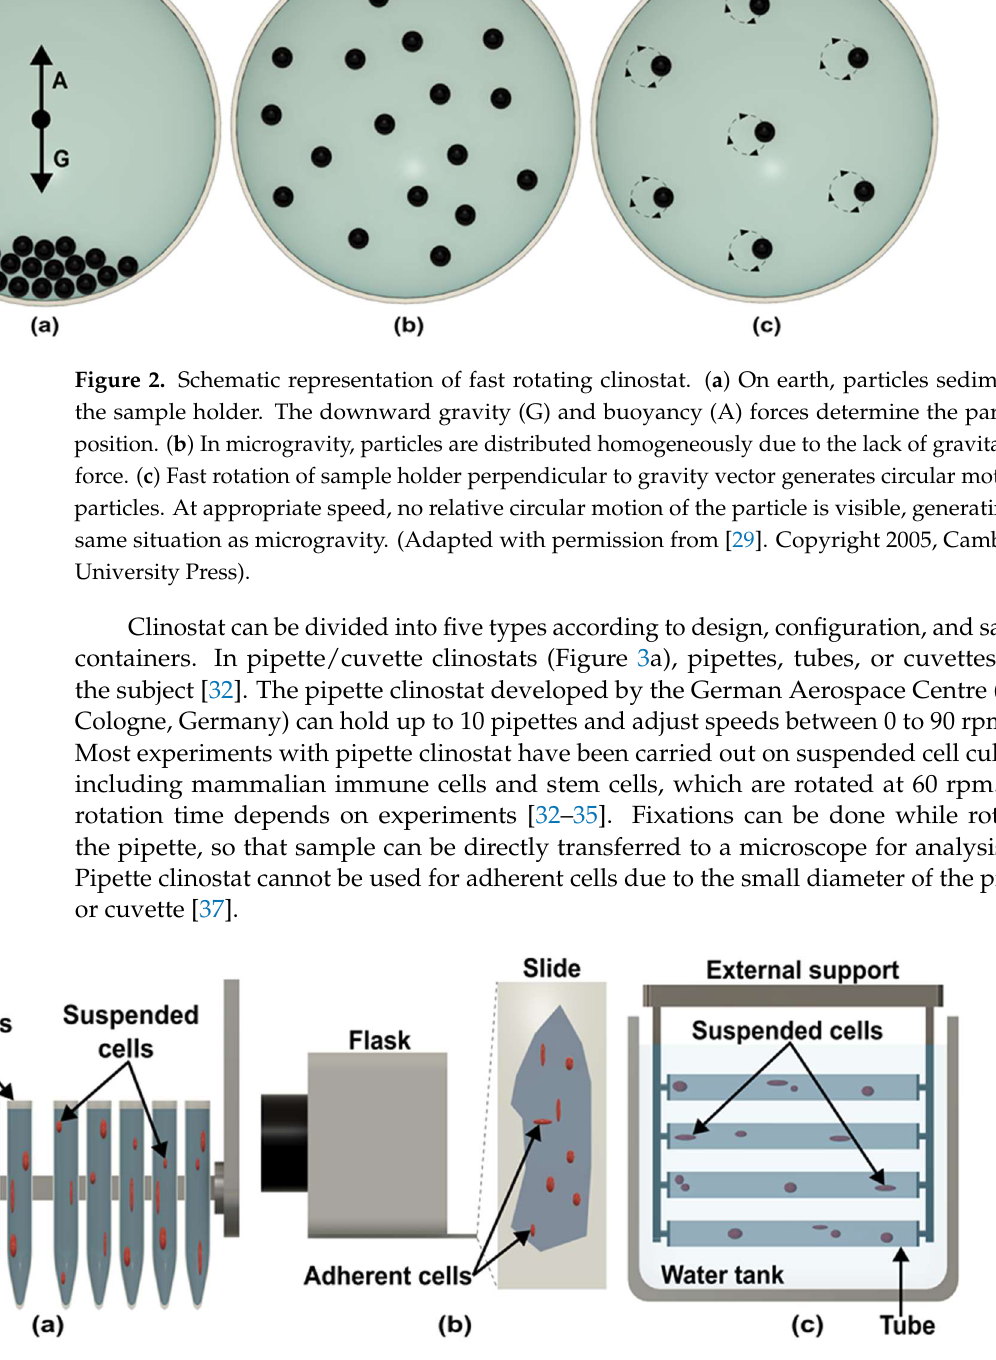
Figure 3. Different designs of clinostat. ( a ) Pipette/cuvette clinostat used for suspended cells. ( b ) Slide-flask used for adherent cells in slide-flask clinostat. ( c ) Scheme of submerged clinostat.